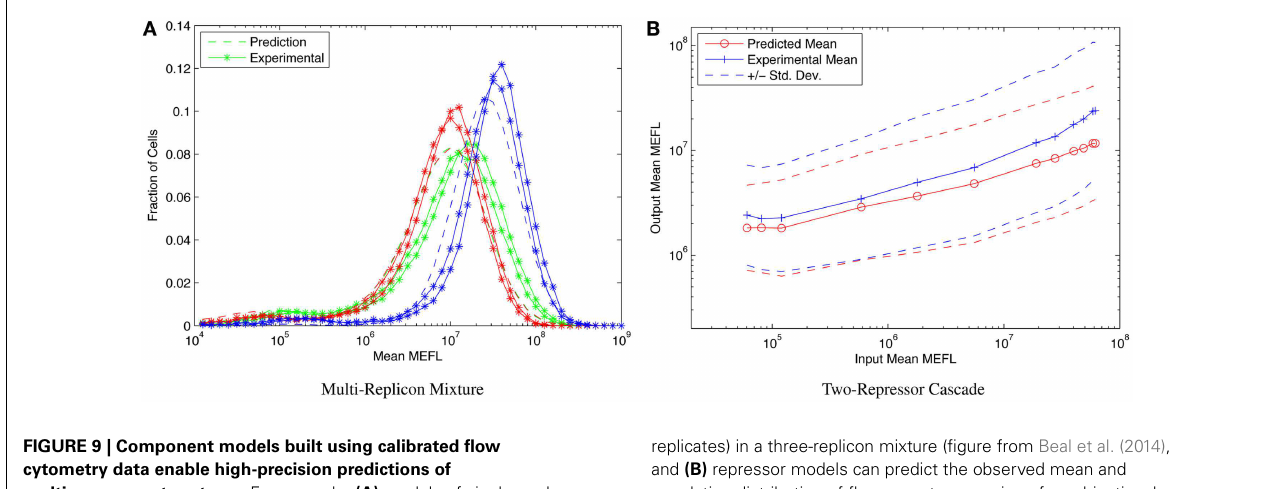
FIGURE 9 | Component models built using calibrated flow cytometry data enable high-precision predictions of multi-component systems . For example, (A) models of single- and dual-replicon transfection can predict (dashed lines) the observed histogram for distribution of fluorescence (lines with stars, two